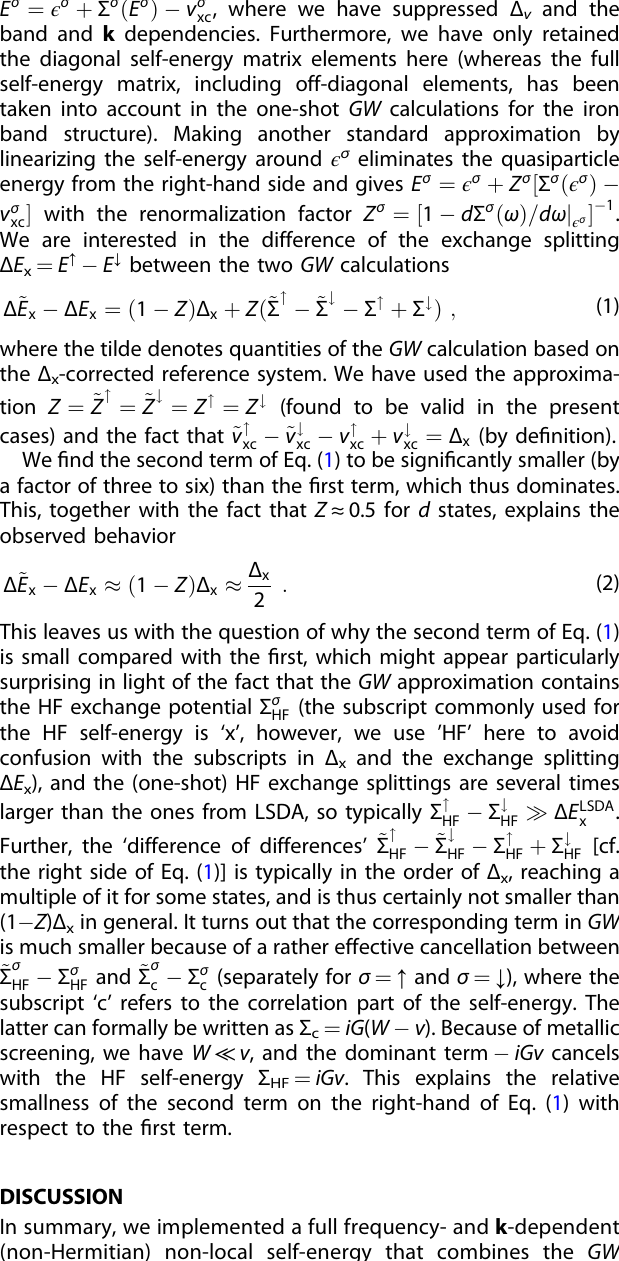
Table 3. The exchange splitting Δ E x at special k points computed with different techniques and compared with available experimental values.